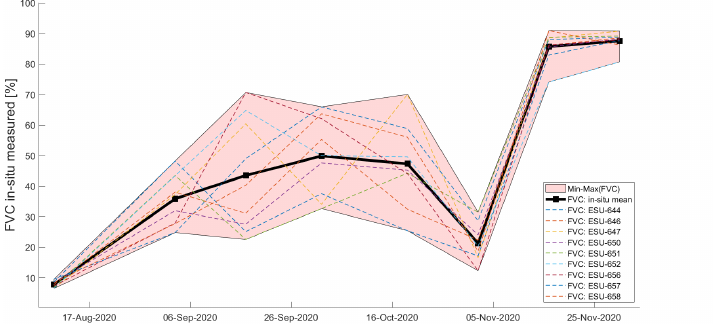
Figure 11. Temporal evolution of wheat crop over the three paddocks at the BVCR study sites described by FVC mean measured values of nine ESUs within the crop limits and the associated SD, which is plotted as shadowed areas.